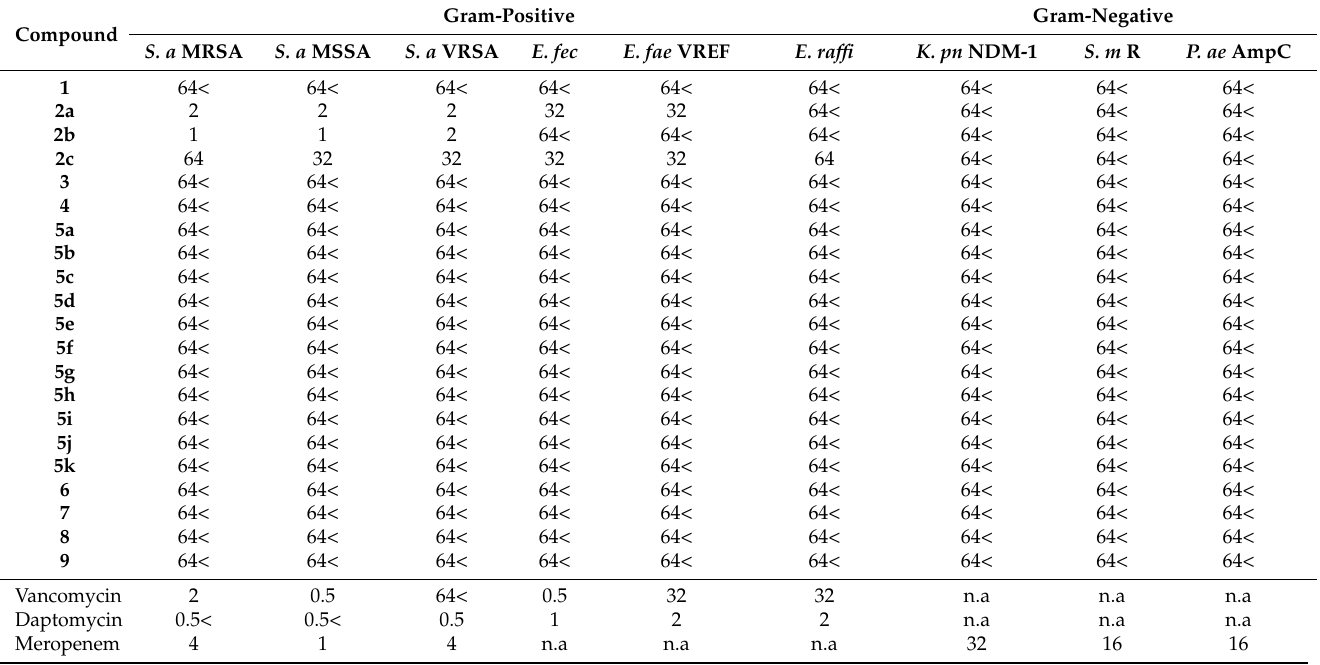
Table 3. The antibacterial activity expressed as minimal inhibitory concentration (MIC, µ g/mL) of compounds 1 – 9 and comparator drugs (vancomycin, daptomycin, and meropenem) against panel of multidrug-resistant Gram-positive and Gram-negative bacterial pathogens harboring different resistance